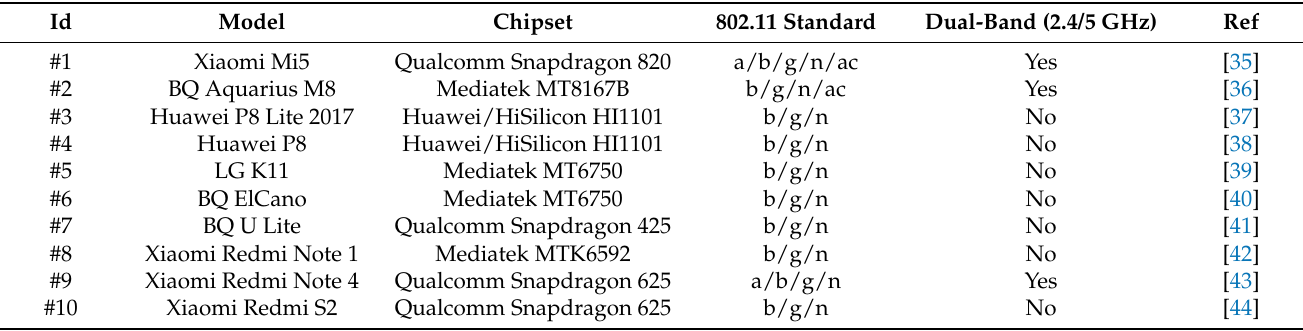
Table 1. Features of the smartphones employed in our